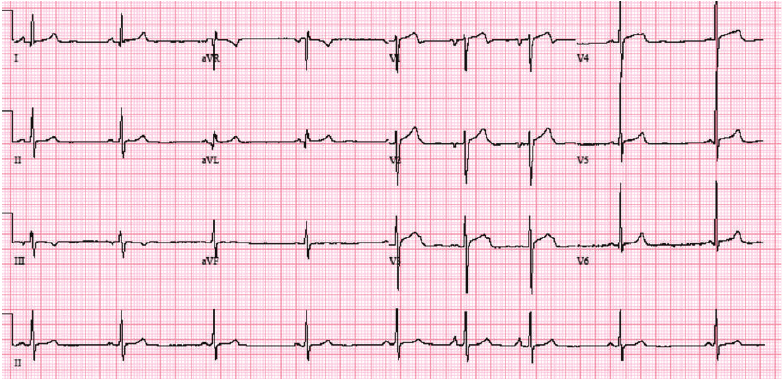
Figure 3: 12 lead ECG after ablation of atrial tachycardia showed sinus bradycardia with sinus arrhythmia (heart rate of 53 bpm). The P waves are now positive in lead II and AVF.